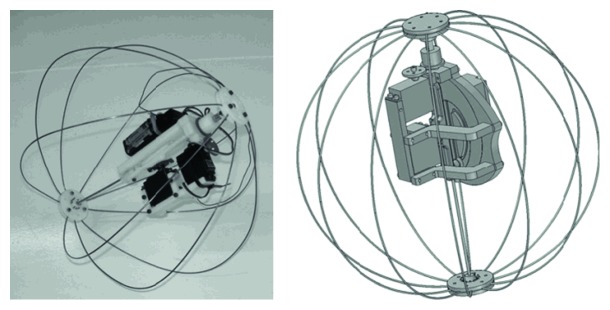
Jumping robot Jollbot [91].